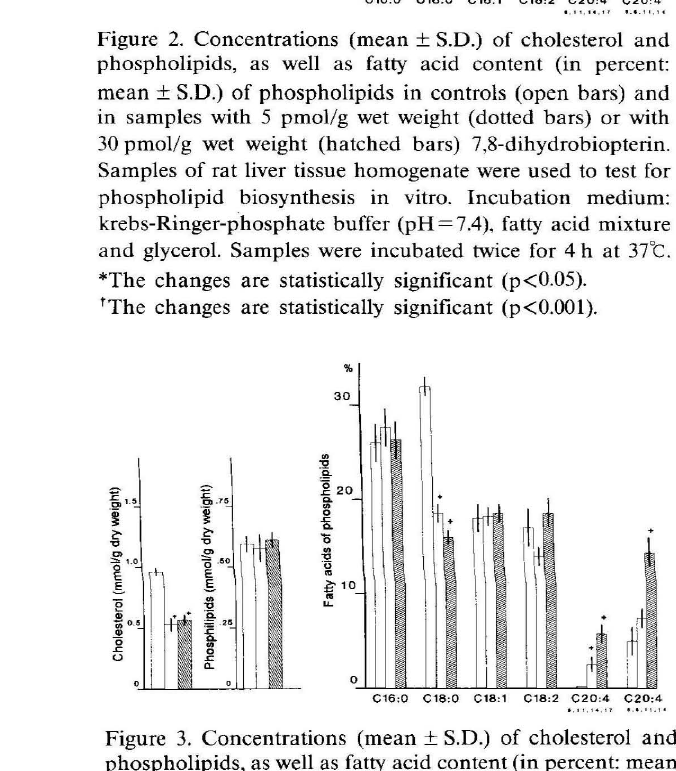
Figure 3. Concentrations (mean ± S.D.) of cholesterol and phospholipids, as well as fatty acid content (in percent: mean ± S.D.) of phospholipids in controls (open bars) and in samples with 5 pmol/g wet weight (dotted bars) or with 30 pmol/g wet weight (hatched bars) 5,6, 7,8-tetrahydrobiopterin. Samples of rat liver tissue homogenate were used to test for phospholipid biosynthesis in vitro. Incubation medium: Krebs-Ringer-phosphate buffer (pH=7.4), fatty acid mixture and glycerol. Samples were incubated twice for 4 h at 37°C. tThe changes are statistically significant (p<O.OOI).